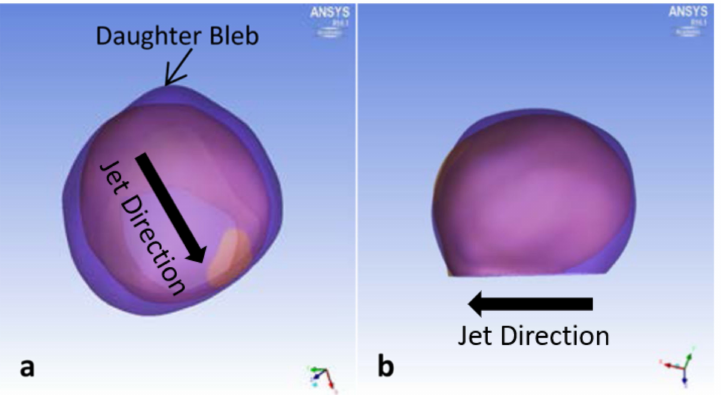
Figure 2. P1 aneurysm growth comparisons between initial diagnosis and follow-up times. ( a ) Top view and ( b ) side view, with block arrows indicating direction of impingement